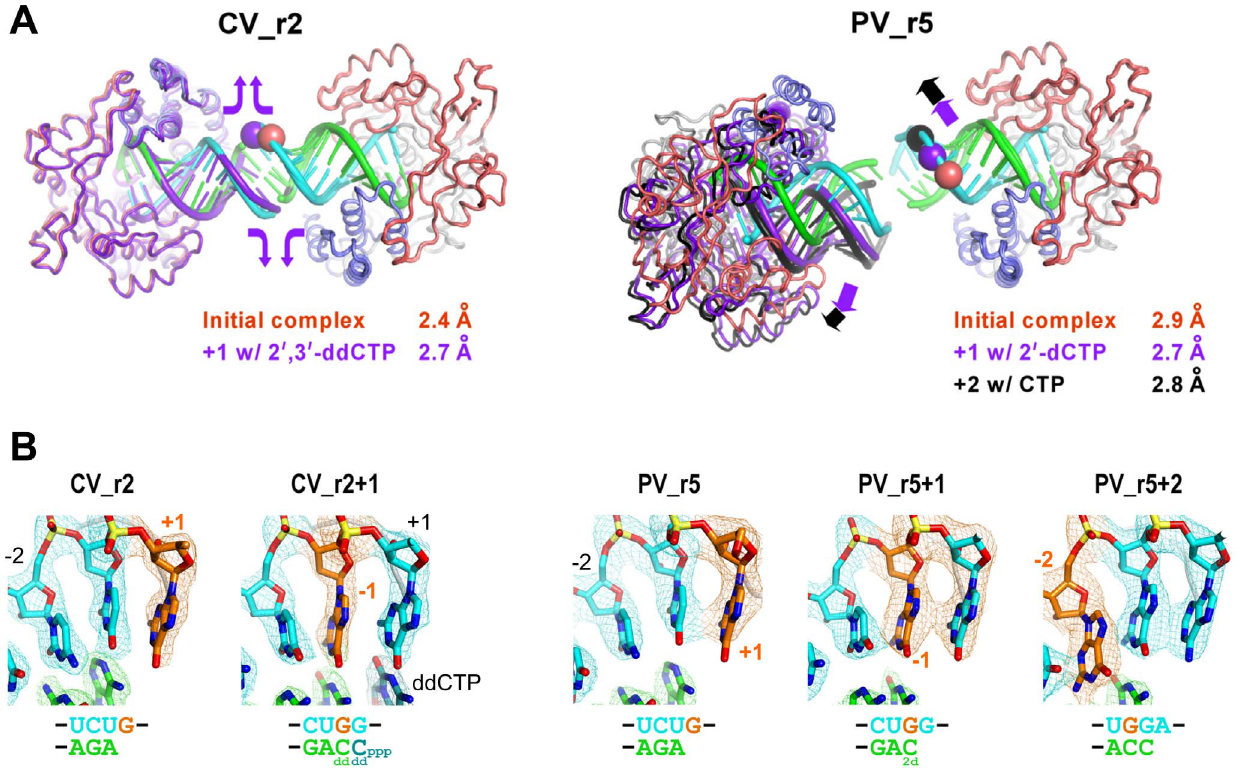
Figure 6. In-crystal translocation upon soaking with NTPs. A) Two different modes of accommodating in-crystal translocation via RNA-RNA junction flexibility. The right side polymerase chain has been superimposed and the multiple positions of the RNA and other ECs are shown in purple for + 1 and black for + 2 elongation states. The CV_r2 complexes undergo one translocation step with only minor changes in polymerase positioning because the junctions ends of the RNA unwind by one base per side to compensate, effectively keeping the upstream duplex length and crystal lattice constant. In contrast, the PV_r5 structure shows significant rotations of one EC relative to the other and repacking of the RNA-RNA junction as the crystal lattice is reshaped to accommodate the longer upstream duplex regions. B) Electron density maps of the template strand showing the movement of the guanosine originally found in the templating + 1 position (orange) into the 2 1 and 2 2 positions on the product side of the active site. 3500 K composite SA-omit maps contoured at 1.5 s are shown for the CV_r2 complexes where soaking with 2 9 ,3 9 -ddCTP results in one incorporation and translocation event and the binding of a second ddCTP in the active site. 2F o –F c maps contoured at 2.0 s are shown for the PV_r5 structures where addition of 2 9 -dCTP results in one incorporation and translocation event while CTP addition results in two cycles of incorporation and translocation.